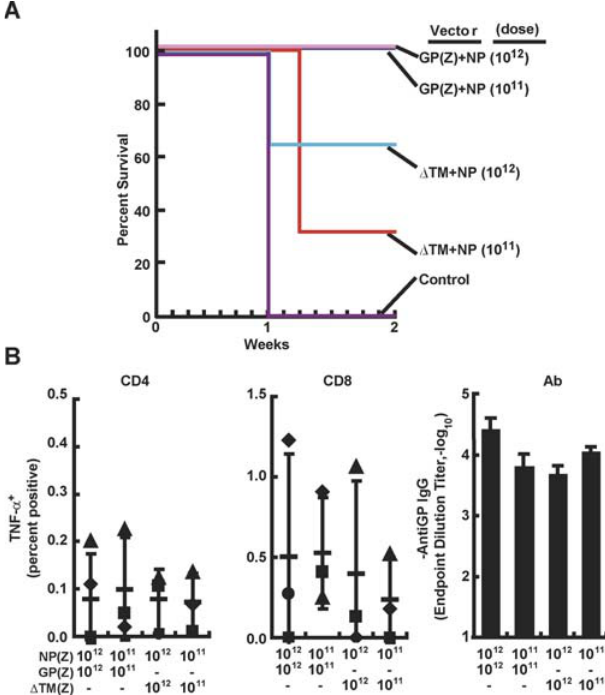
Figure 2. Comparative Efficacy of GP and GP D TM for Protection against Ebola Virus Challenge (A) Kaplan-Meier survival curve of cynomolgus macaques, immunized as indicated, and challenged with 1,000 pfu of Zaire ebolavirus (strain Kikwit) 1 mo post immunization. The x -axis indicates weeks post- challenge. Different immunization groups had n ¼ 3, except for the GP(Z) þ NP (10 12 ) group ( n ¼ 4), and control ( n ¼ 1). (B) Immune responses in immunized animals. Left and middle graphs: Intracellular flow cytometry was performed to quantify TNF- a production from Ebola-specific CD4 þ or CD8 þ lymphocytes, respectively, from animals immunized as indicated (the 10 12 group contains only three CD8 points due to technical error in one sample). Immune responses were measured at 3 wk postimmunization. Circles, diamonds, squares, and triangles indicate responses for individual animals. Horizontal line indicates the average of individual responses in the immunization group. Results represent the percent cytokine-positive in the gated lymphocyte group, and background stimulation (DMSO alone) has been subtracted from each sample. ELISA titers of Ebola GP-specific antibodies in sera of vaccinated animals collected at week 3 postimmunization (right graph). ELISA results represent endpoint dilution titers determined by optical density as described in Methods. DOI: